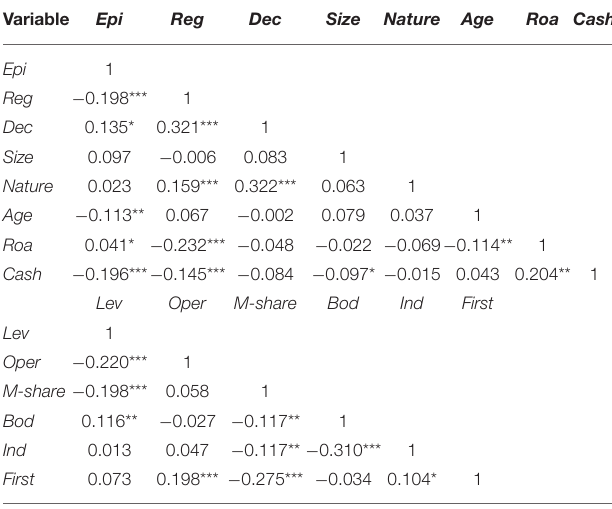
TABLE 3 | Correlation matrix of